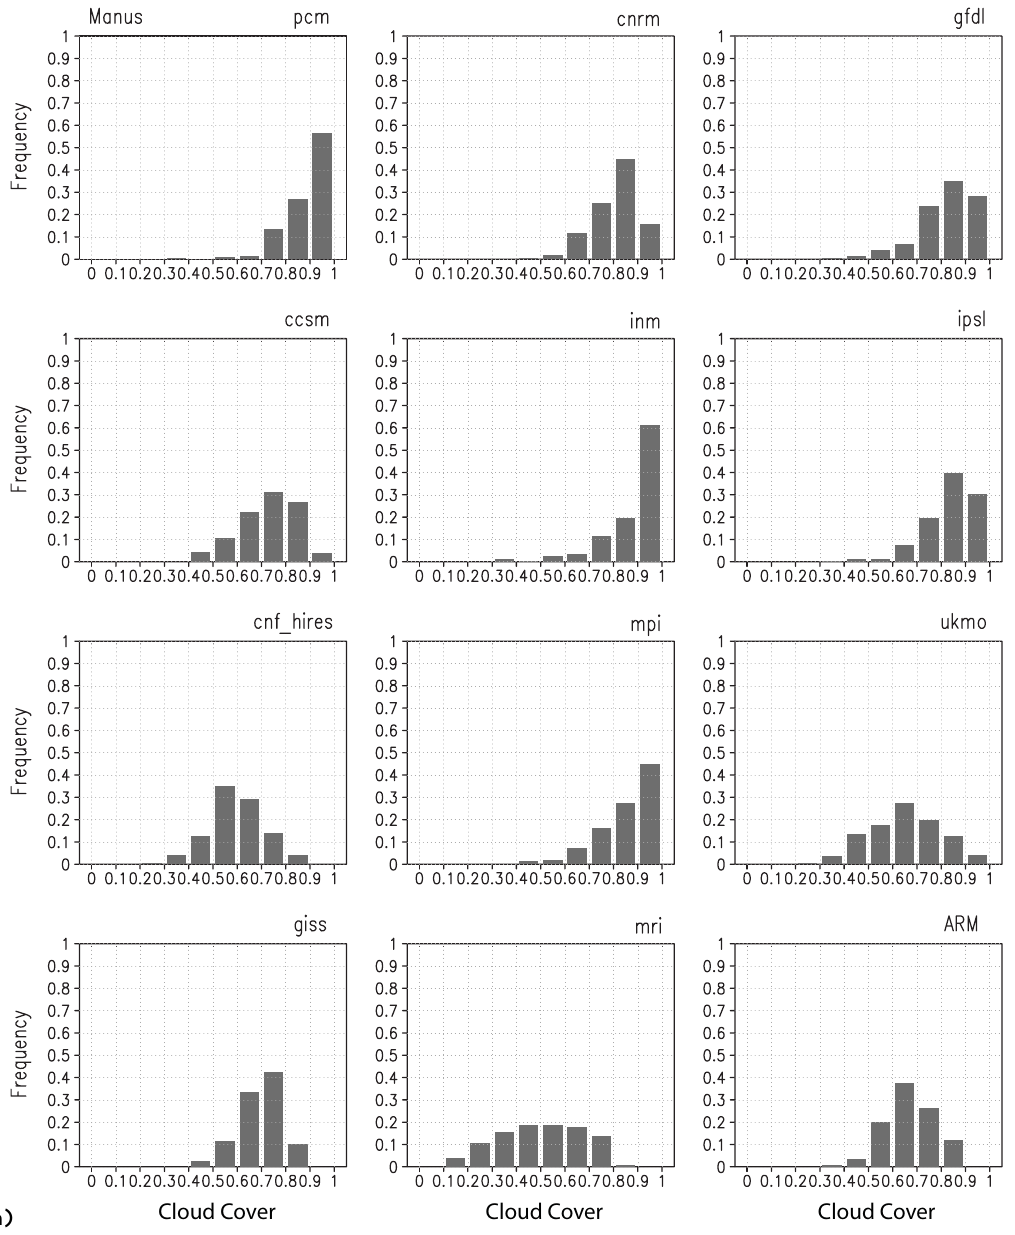
Fig. 7. The frequency of occurrence (PDF) of monthly mean TCF simulated by 11 GCMs and calculated from observation over three ARM sites. (a) Manus, (b) SGP, and (c)